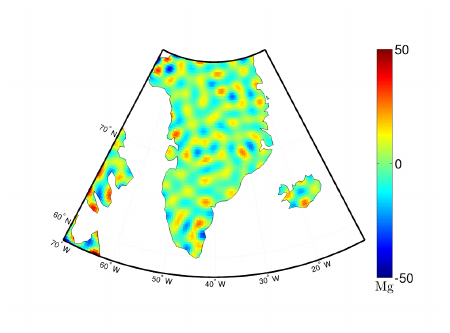
Fig. 9. Ice sheet residual mass change between November 2009 and June 2010 observed using GOCE T ZZ gradients.